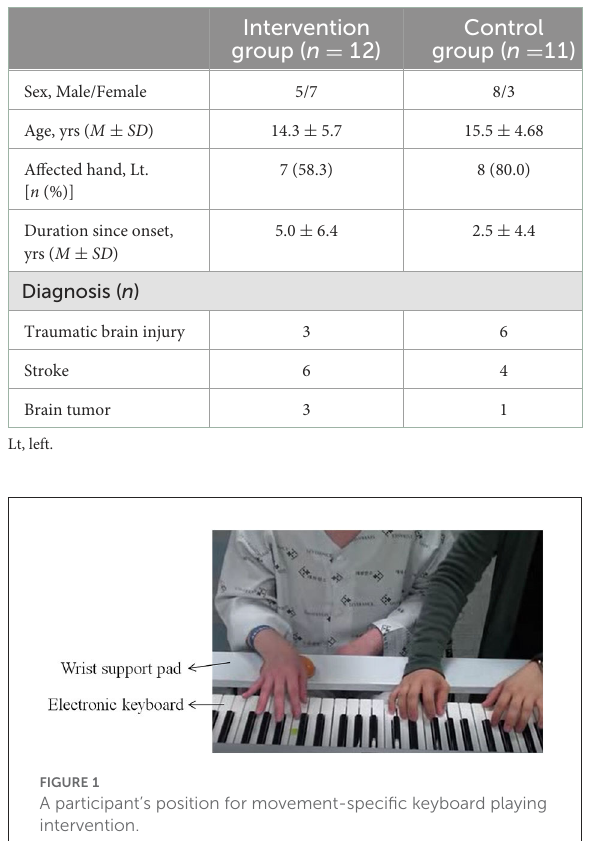
TABLE 1 Demographic information of participants.